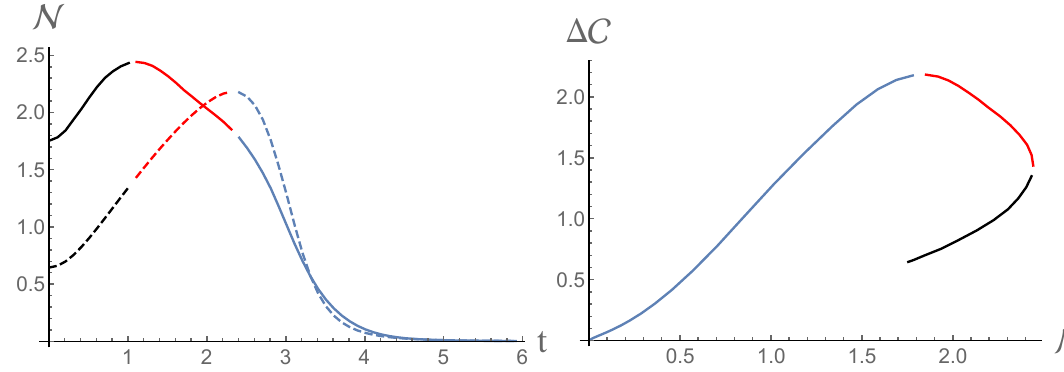
Figure 5 . Left plot: time dependence of the integrated entanglement density N (solid) and the volume complexity (dashed) of the interval x 2 ( (cid:0) 3 ; 3) at M = 0 : 2 ; (cid:11) = 0 : 5. Right plot: the relation between the (rescaled) subsystem volume complexity (cid:1) C and N